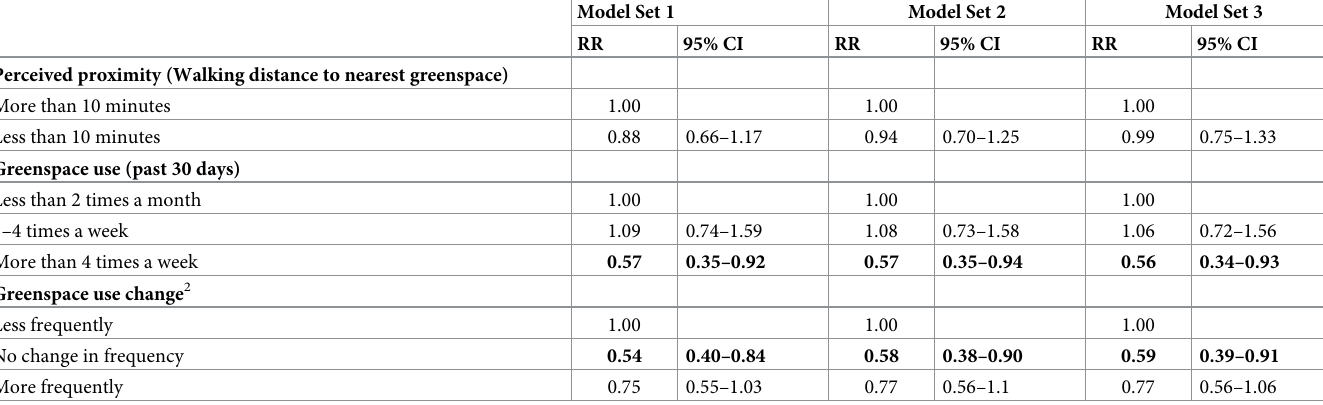
Table 6. Estimates of association between the greenspace measures and worsened physical health, comparing the survey period to before the start of pandemic- related social distancing measures in March of 2020 1